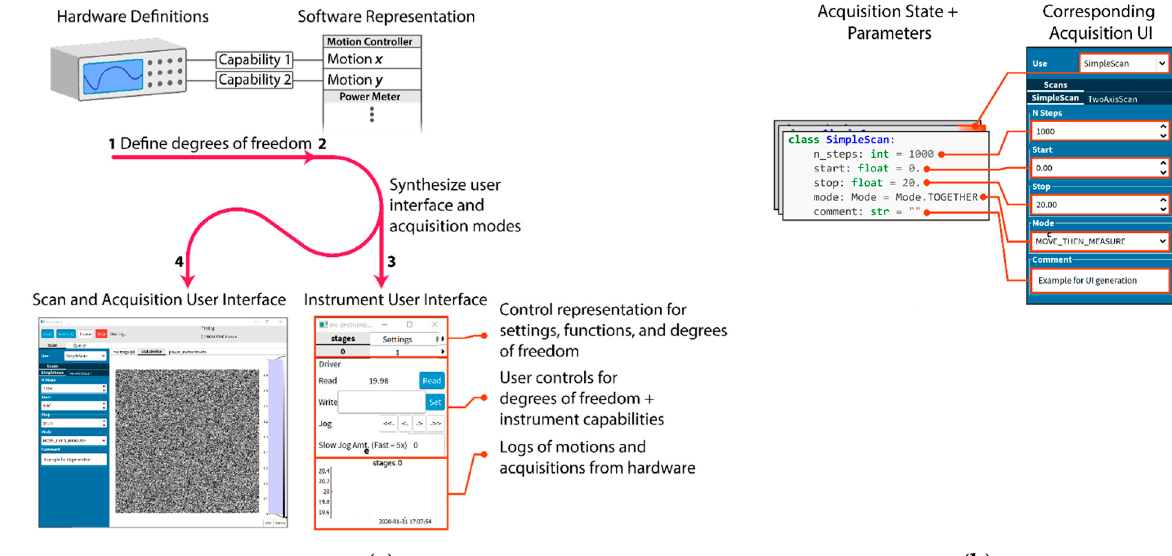
Figure 1. User interface generation. (( a ), 1–4) Elements of the default user interface provided by AutodiDAQt and their correspondence to data acquisition hardware. ( a1 ) Acquisition hardware and software drivers express degrees of freedom (axes) and capabilities (settings, functions) for instruments. ( a2 ) Hardware capabilities are mapped to a uniform representation for experimental degrees of freedom and experimental states in AutodiDAQt. In certain contexts, this mapping can be semantics of an experiment is available. Device semantics cover details of how to invoke instrument methods to control hardware, limits on values, their concrete types, and their role in an experiment.